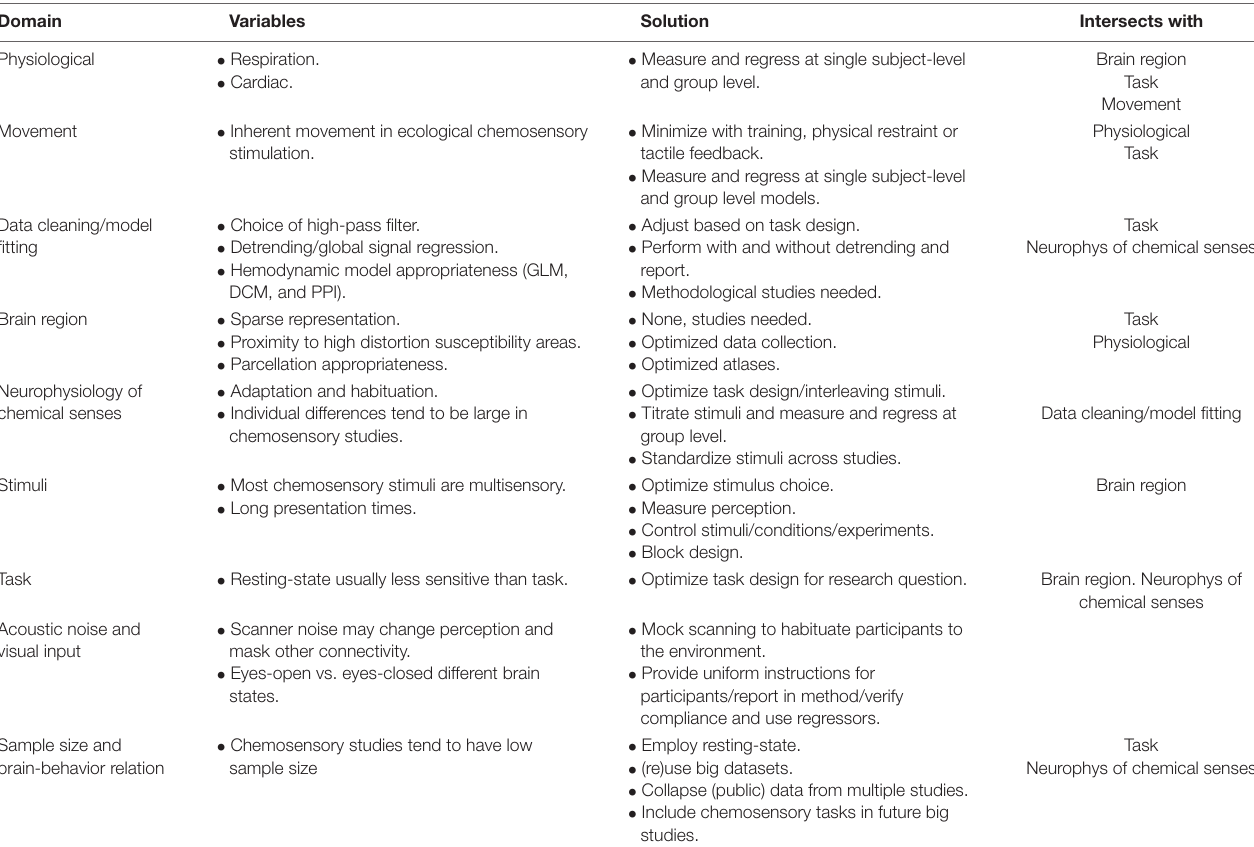
TABLE 1 | Description of challenges to chemosensory connectome neuroimaging studies.